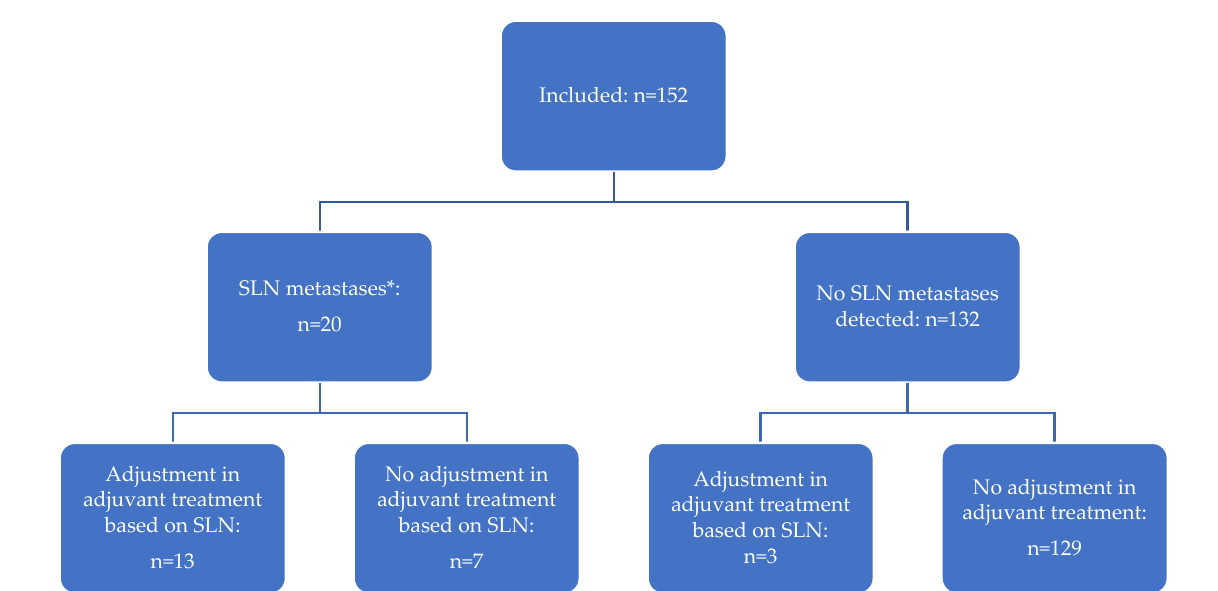
Figure 2. The contribution of SLN mapping in the management of patients with presumed early-stage, low- and intermediate-risk EC. * Includes macro-metastases ( n = 10), micro-metastasis ( n = 7), and isolated tumor cells ( n = 3).